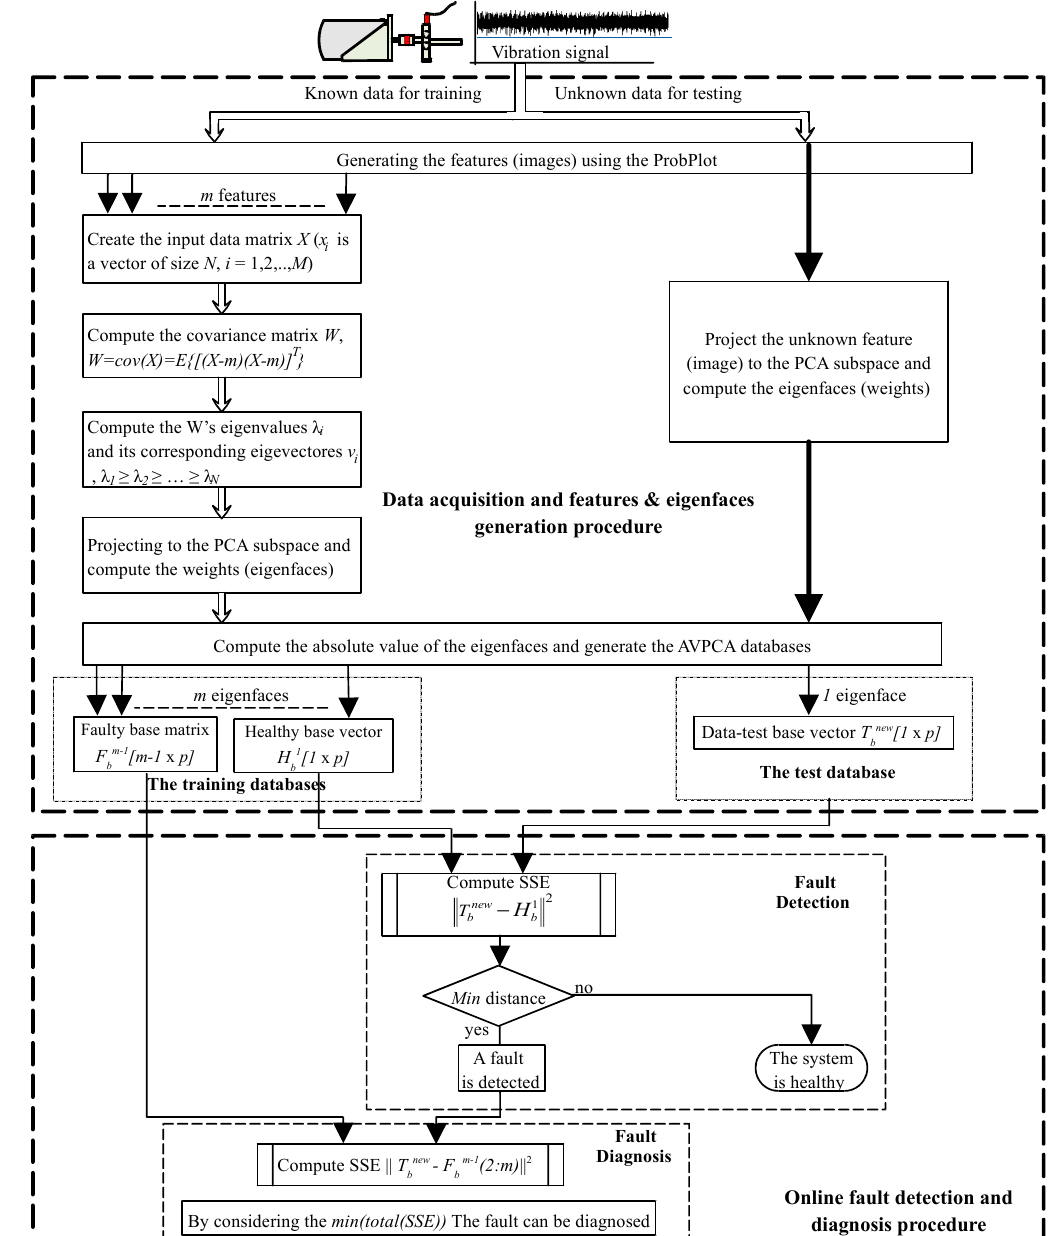
Figure 3. The overall bearing fault detection-based ProbPlot via IR-AVPCA technique flowchart.